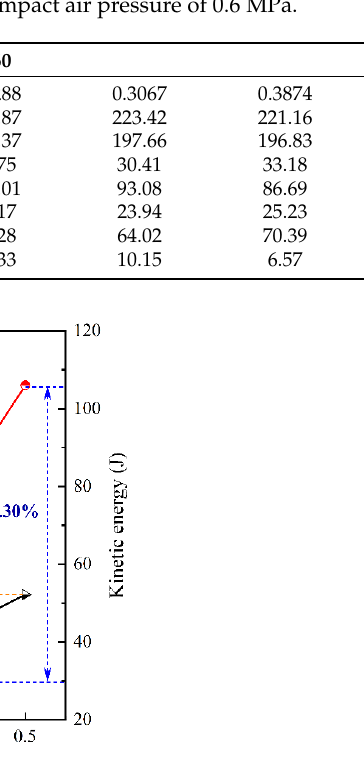
Figure 18. Variation of energy distribution with accumulated damage variable. Figure 19. Variation of fracture energy and energy efficiency with accumulated damage variable.